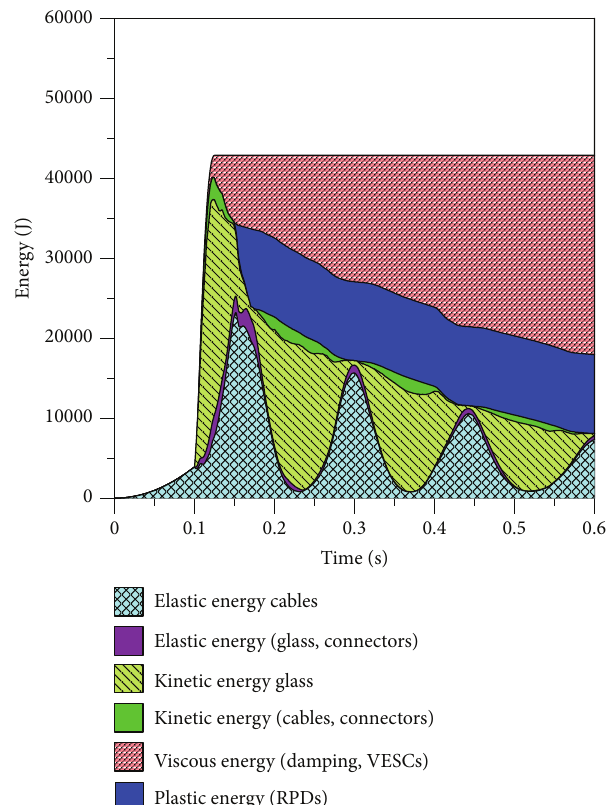
Figure 14: Energy terms for the fac¸ade-module equipped by multiple devices (VESCs and RPDs,